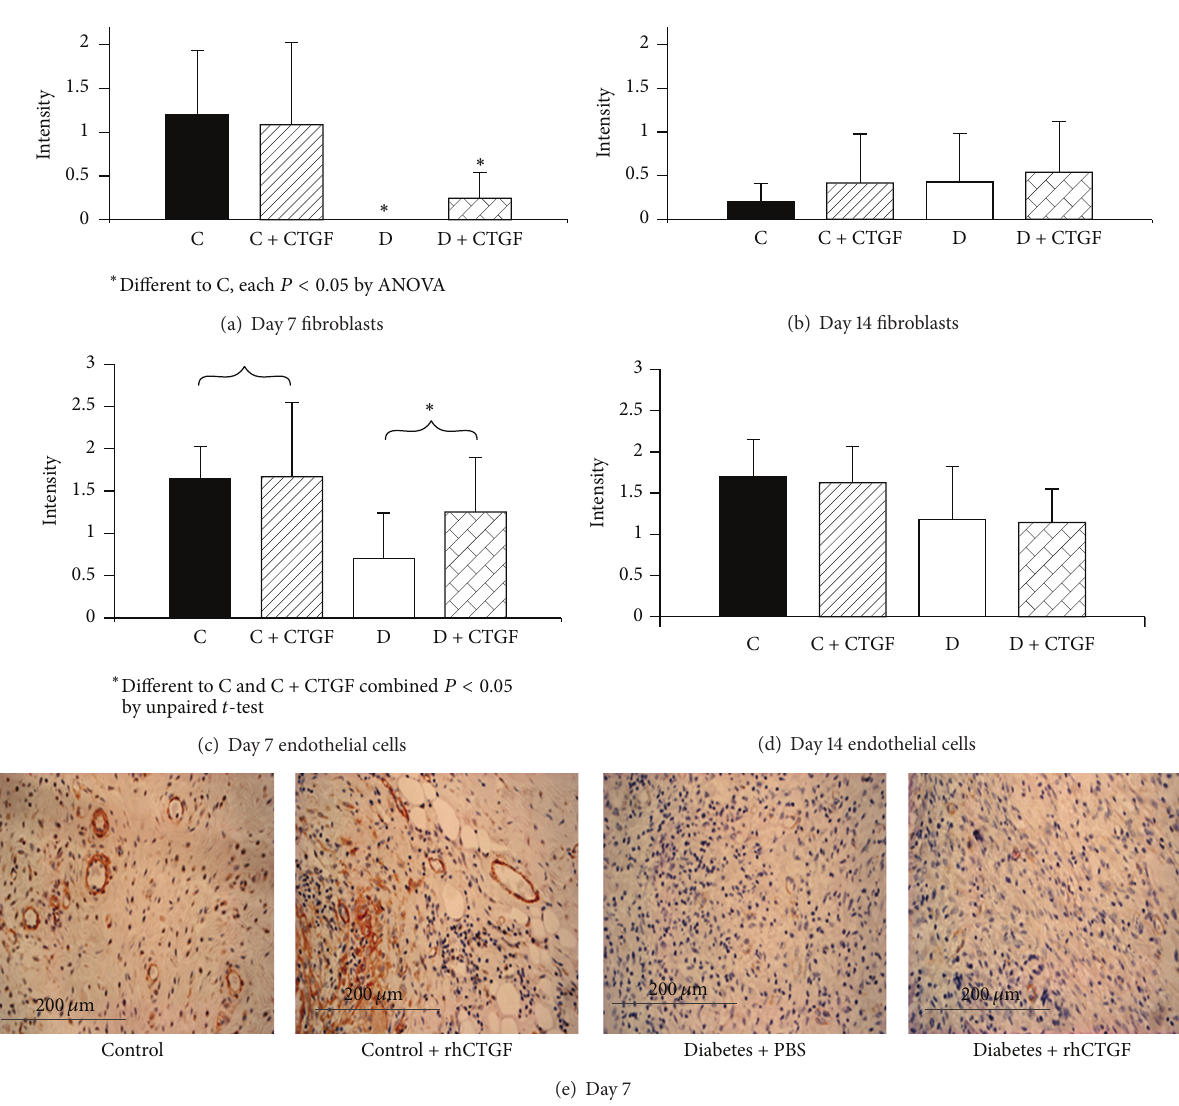
Figure 2: Wound 𝛼 -smooth muscle actin staining in fibroblasts and endothelial cells. (a) shows 𝛼 -SMA staining intensity scoring in fibroblasts, in treated control animals compared with the two diabetic animal groups, at day 7; ∗ 𝑃 < 0.05 by ANOVA for each of the groups marked versus Control + CTGF. No such differences were observed at day 14 in (b). In (c) increased 𝛼 -SMA staining in endothelial cells was observed at day 7 in control animals (treated and untreated combined) compared with diabetic animals (treated and untreated combined); ∗ 𝑃 < 0.05 by unpaired 𝑡 -test. No such differences were observed at day 14 (d). Results are expressed as mean ± SEM. Representative images at day 7 are shown in